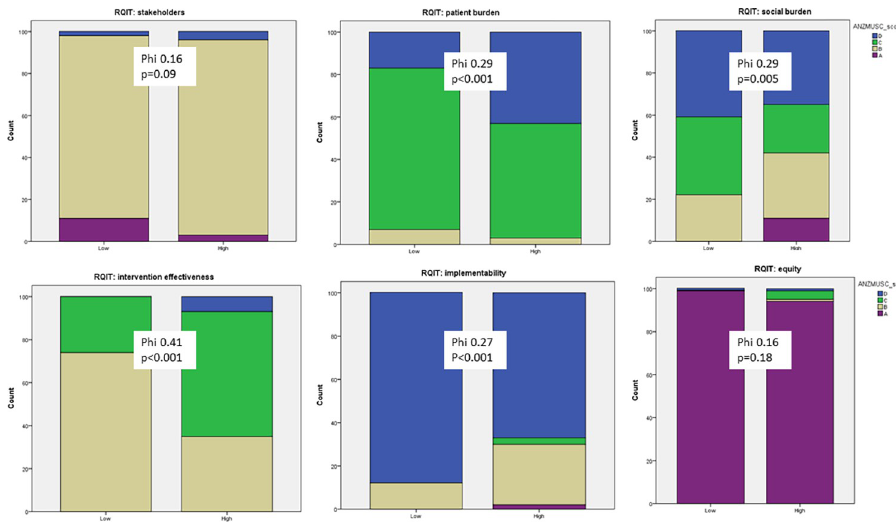
Fig 3. The level of association between dimensions of RQIT shown as counts of publications by journal impact factor (low, high) and by categories of the RQIT assessment. The Phi (also known as Cramer’s V) statistic can be interpreted in a similar way as a correlation